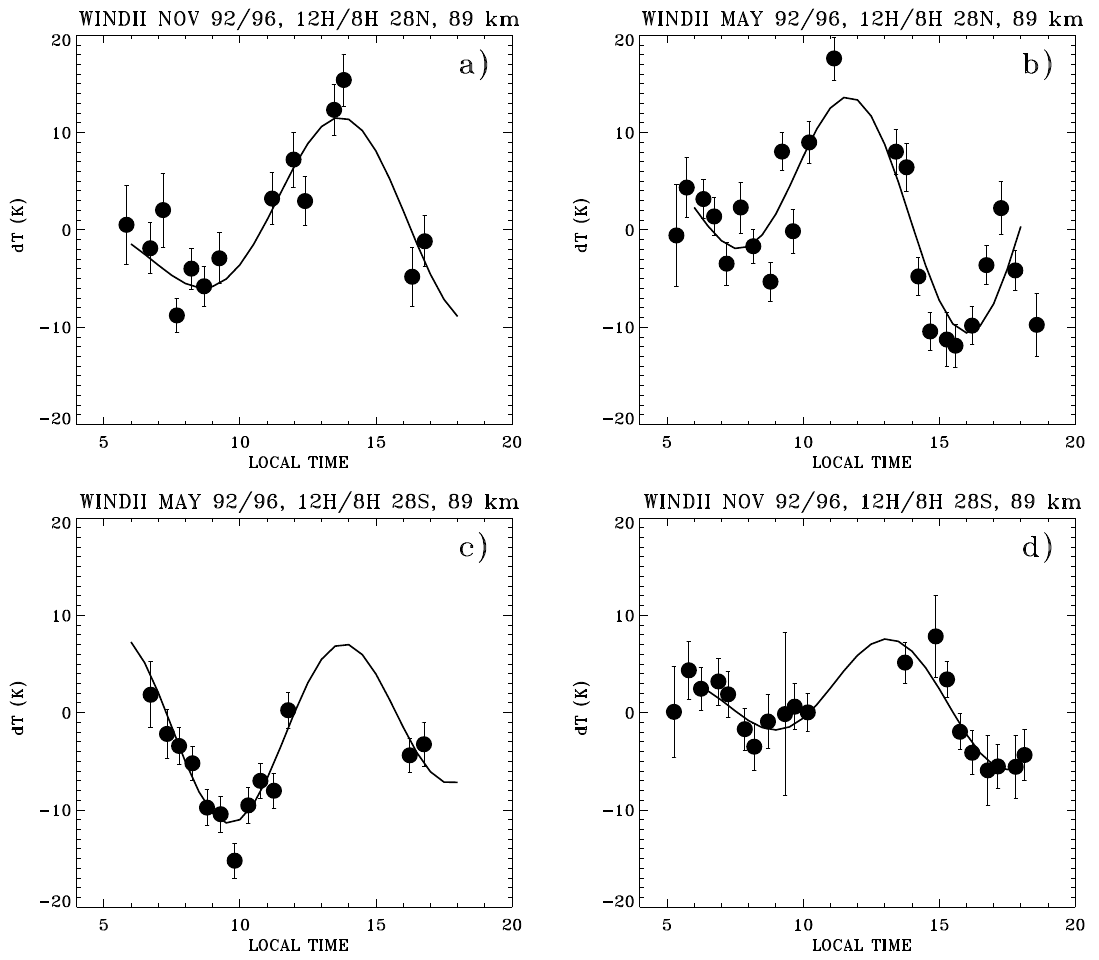
Fig. 3. WINDII temperature semidiurnal and terdiurnal tidal fits at 28 ◦ N (a), (b) and 28 ◦ S (c), (d) for the months of November and May. The temperature data are composites of observations from 1992 to